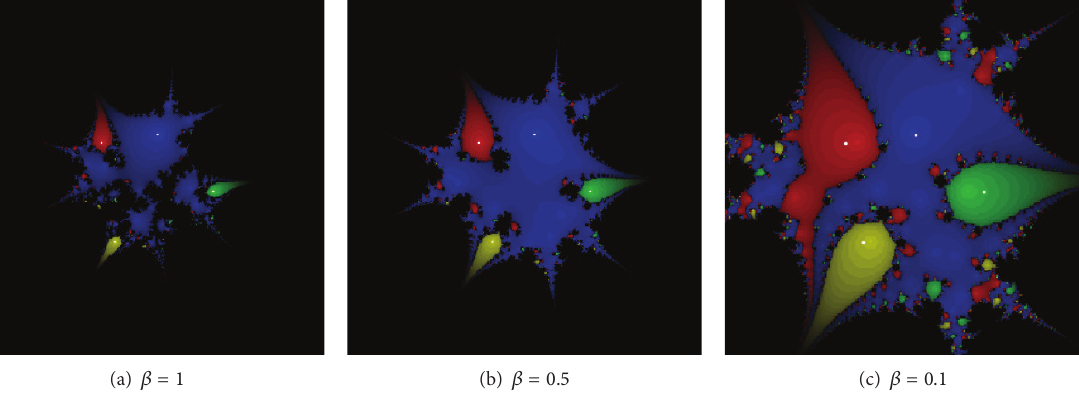
Figure 7: Scheme (3) for the test problem 4.